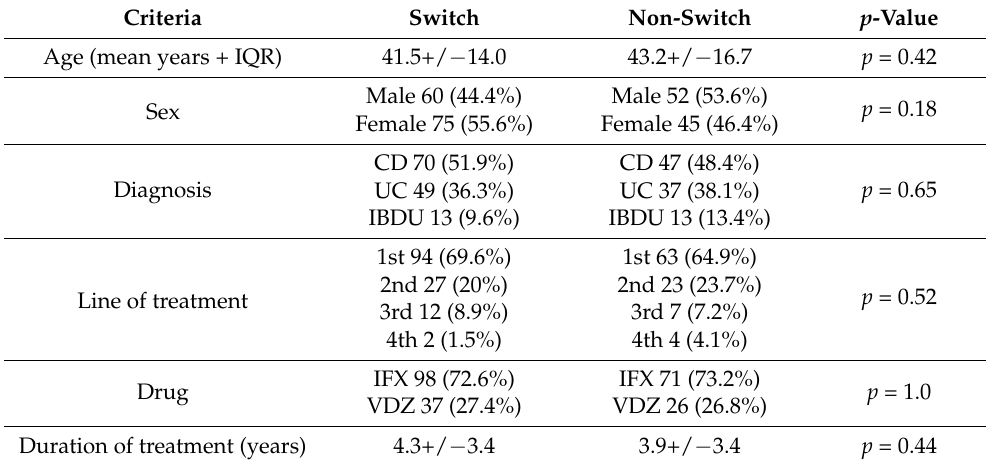
Table 1. Cohort characteristics and factors potentially associated with willingness to